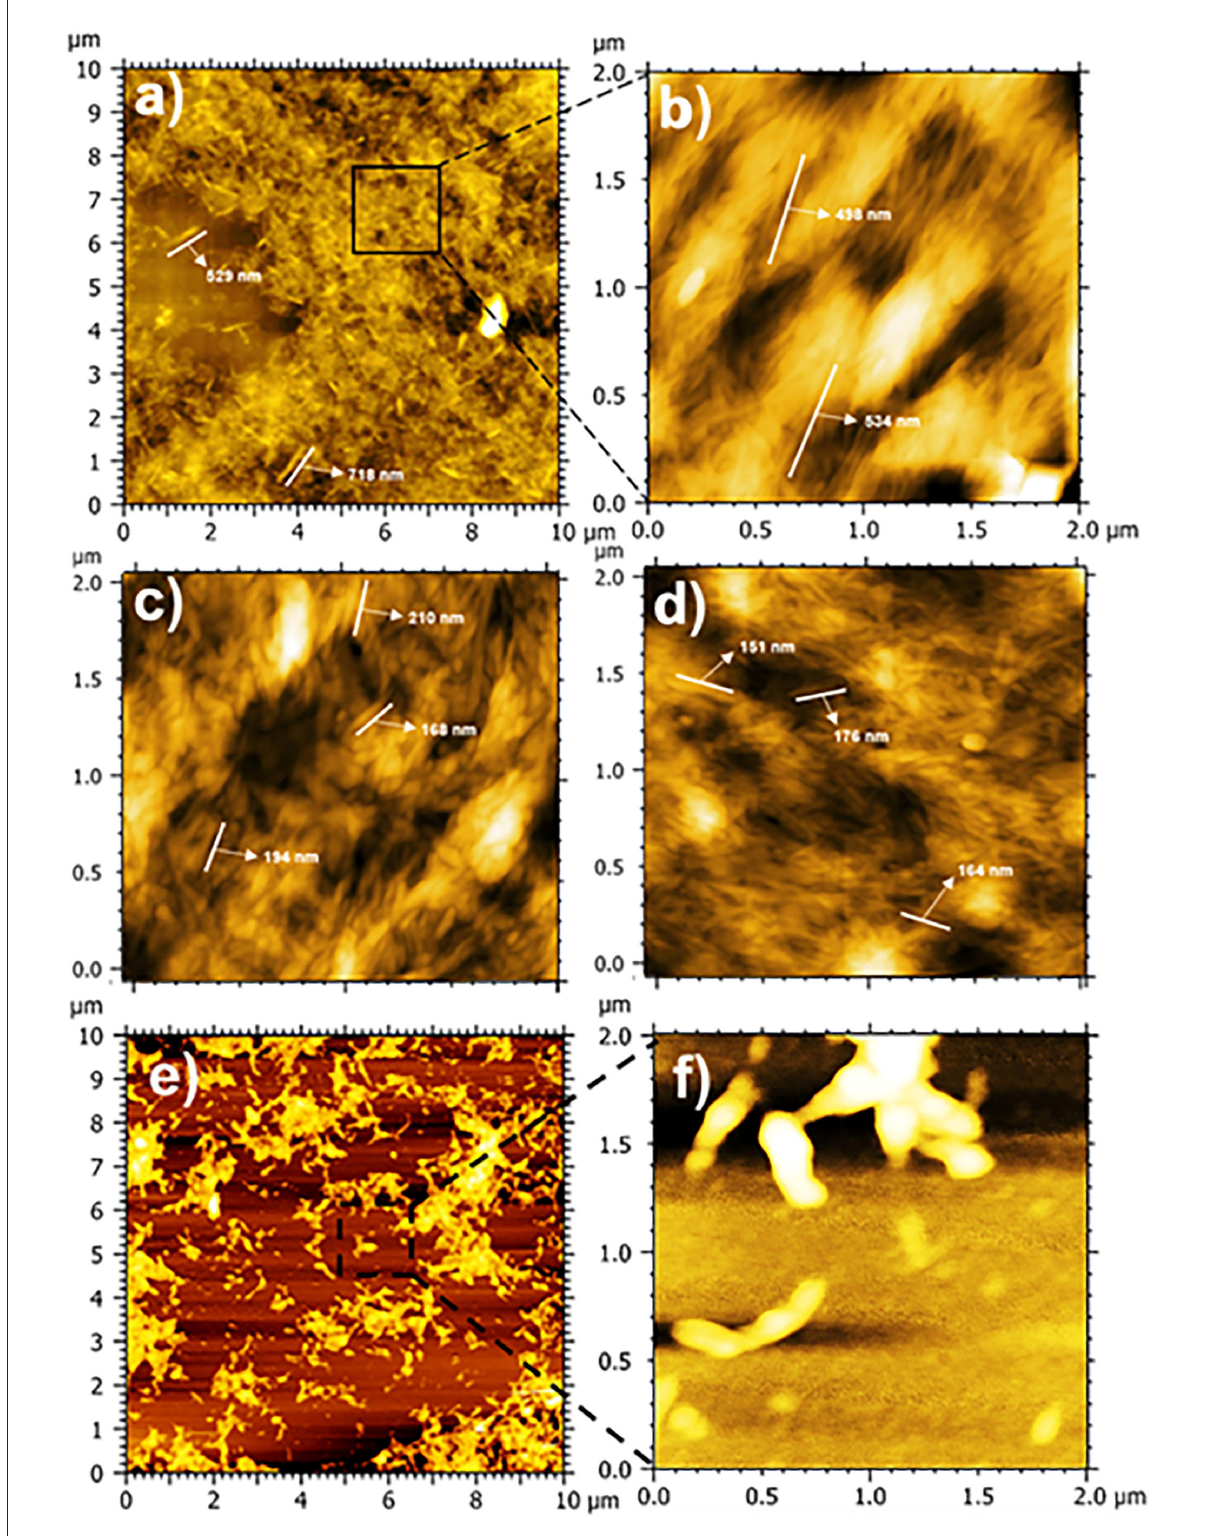
FIGURE6 Atomic Force Microscopy (AFM) images of CNCs derived from garlic stalk (a, b) , corncob (c) , and giant cane cut-up (d) extracted by means of sulfuric acid. Panels (e, f) show AFM images of CNCs from giant cane cut-up extracted using hydrochloric